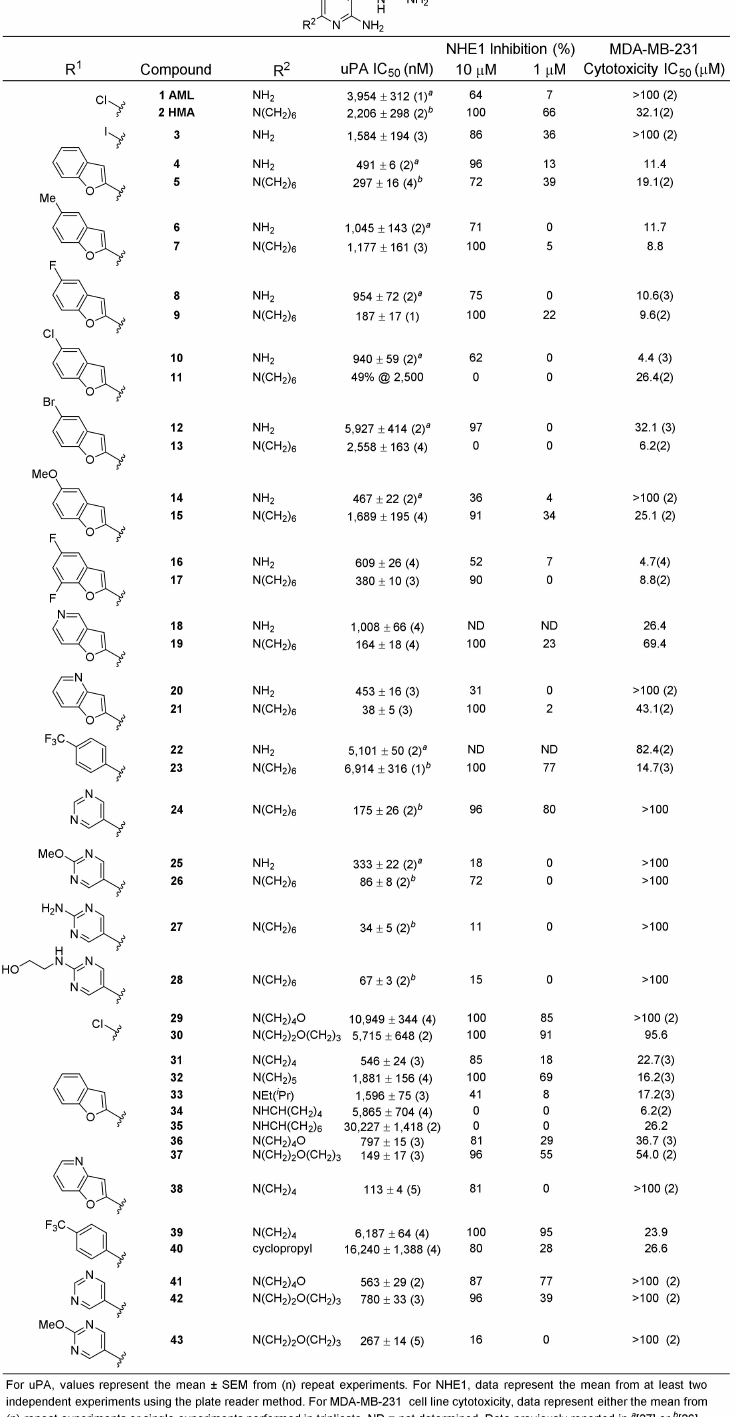
Figure 1. Urokinase-type plasminogen activator (uPA) and sodium-hydrogen exchanger isoform-1 (NHE1) inhibition and cytotoxicity data for 5- and 6-substituted amilorides. The trend was also seen with other substituted pyrimidines, with the amino 27 and ethanolamine 28 substituted HMA analogs and methoxypyrimidine amiloride 25 showing only 11–18% inhibition at 10 µ M. Collectively, the uPA and preliminary NHE1 screening data indicate that the substituted pyrimidines are potentially compounds with selectivity for uPA. Additionally, the data indicate that the parent unsubstituted pyrimidine 24 is a possible dual-targeting uPA/NHE1 inhibitor, and that the 6-Cl-5-morpholino 29 , 1,4-oxazepine 30 , and the 6-(4-CF 3 - phenyl) pyrrolidine 39 analogs are potential NHE1-selective